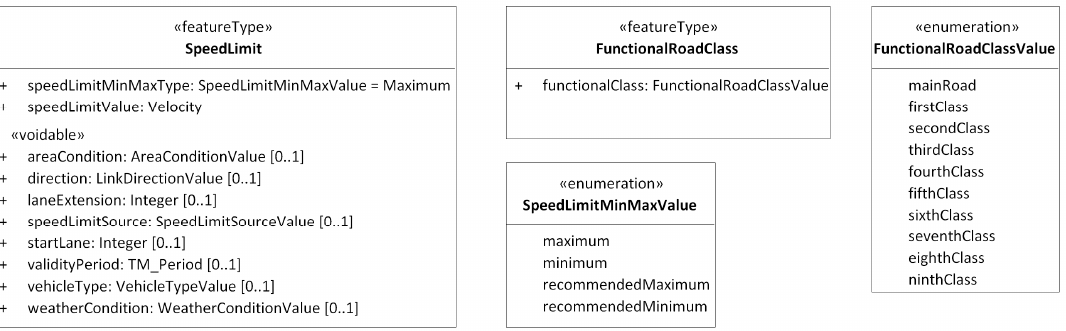
Figure 9. INSPIRE SpeedLimit and FunctionalRoadClass.